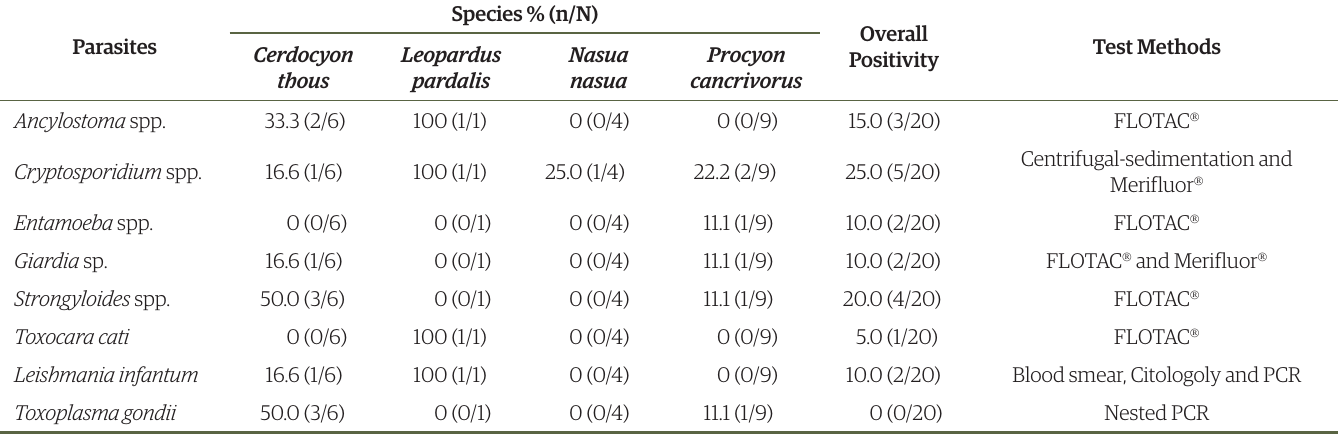
Table 3. Zoonotic parasites in nonhuman primates from the traffic of wild animals in the Northeastern of Brazil. Species % (n/N) Parasites Sapajus Overall Positivity Callithrix jacchus libidinosus Ancylostoma spp. Cryptosporidium spp. Centrifugal-sedimentation and Merifluor  Entamoeba spp. Giardia spp. Strongyloides spp. Taenia spp. Toxoplasma